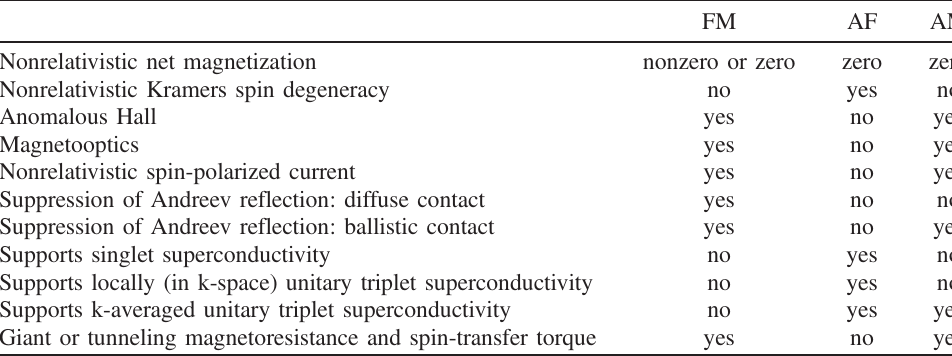
TABLE I. A comparative summary of the phenomenological similarities and differences between altermagnets and the familiar ferromagnets as well as antiferromagnets.